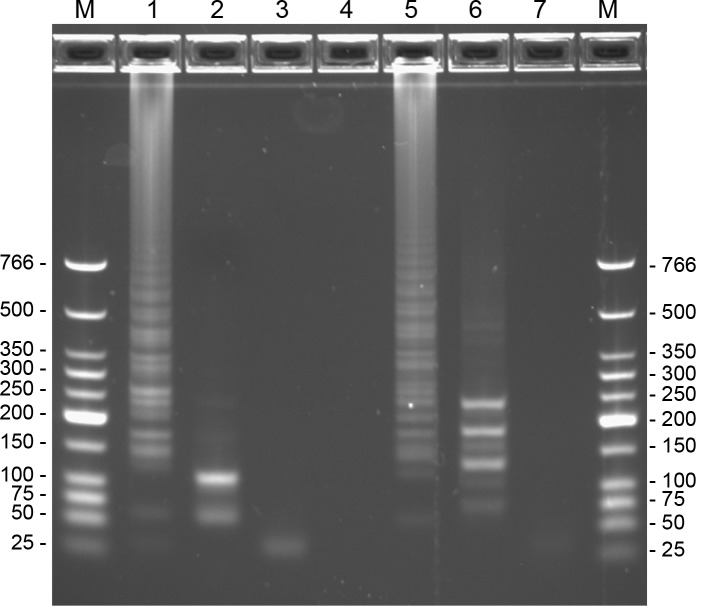
Electrophoretic analysis of RT-LAMP amplification products with WEEV nsP4 and SLEV 3’ UTR primer sets.The gel is a 2% agarose E-gel (Invitrogen) with ethidium bromide. The marker (“M”) is a Low Molecular Weight DNA Ladder (New England Biolabs). Lane 1: WEEV positive control reaction with 2 PFU equivalent WEEV RNA in 20 μL. Lane 2: WEEV positive control after digestion with XbaI. Lane 3: No-template control reaction with WEEV nsP4 primer set. Lane 4: no sample. Lane 5: SLEV positive control reaction with 2 PFU equivalent SLEV RNA in 20 μL. Lane 6: SLEV positive control after digestion with HindIII. Lane 7: No-template control reaction with SLEV 3’-UTR primer set. Cutting sites within the amplicon regions are shown in Figs 1 and 2.